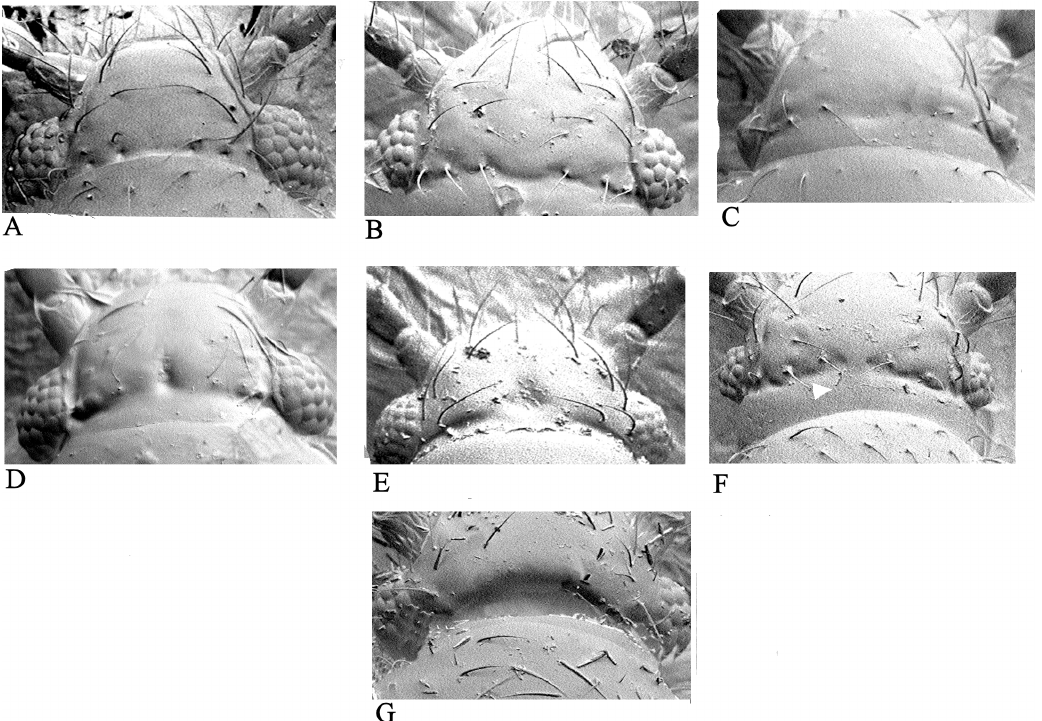
Fig. 3. Figures to show differences in morphological features of head between eyes. A . Cissidium upiense sp. nov., × 565. B . Cissidium sueae sp. nov., × 480. C . Cissidium delicatum sp. nov., × 1060. D . Cissidium foveolatum Johnson, 1982, × 730. E . Cissidium basale Motschulsky, 1855, × 385. F . Cissidium ibicarense sp. nov., × 505. G . Cissidium eciton sp. nov., × 650.